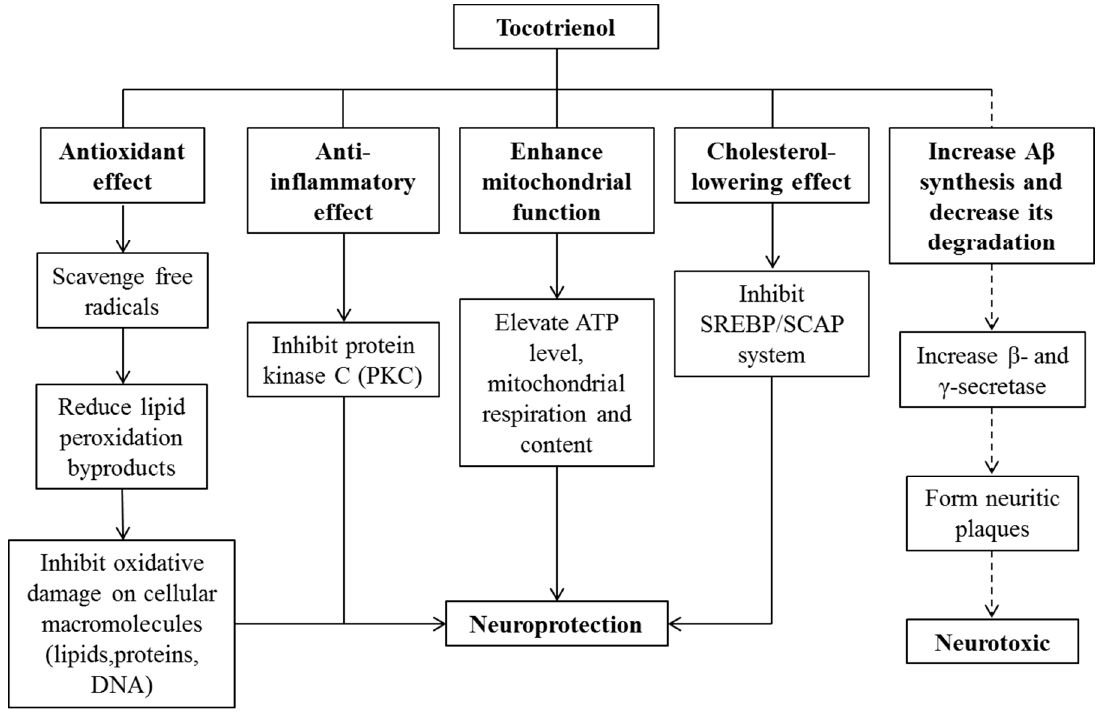
Figure 8. E ff ects of T3 on Alzheimer’s disease. Solid lines represent advantageous e ff ects of T3 while Figure 8. Effects of T3 on Alzheimer’s disease. Solid lines represent advantageous effects of T3 while the dotted lines represent possible harmful e ff ects of the dotted lines represent possible harmful effects of T3.